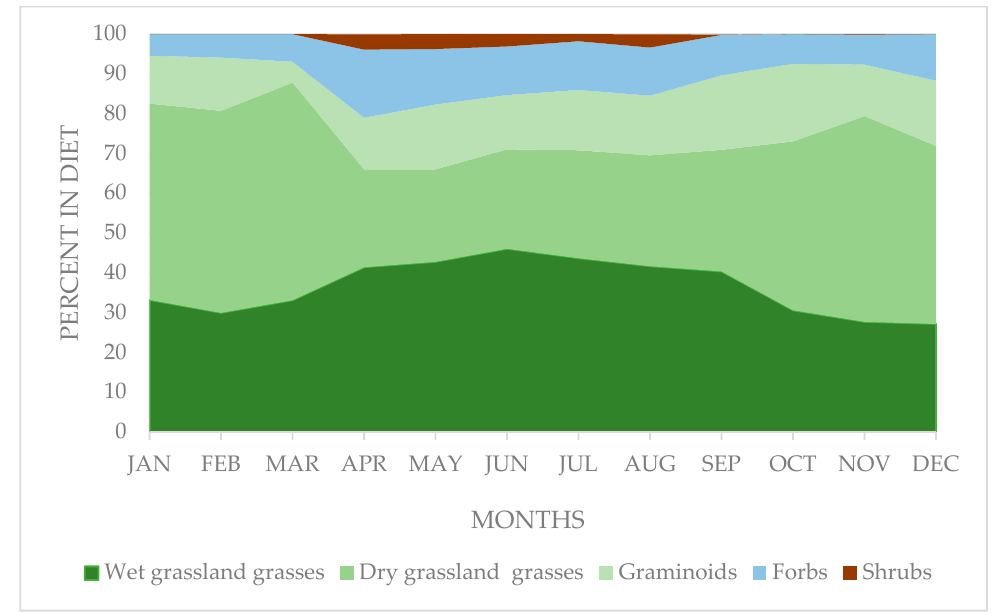
Figure 3. Monthly variation in the contribution of the main functional groups of plants in the vicuña diet in natural grasslands of a sector of the Chilean highlands.